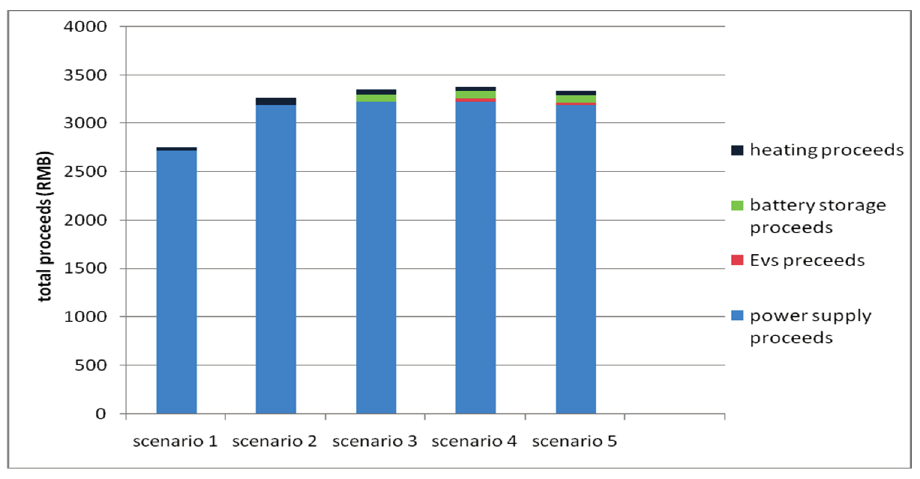
Figure 4. The micro grid profits in different